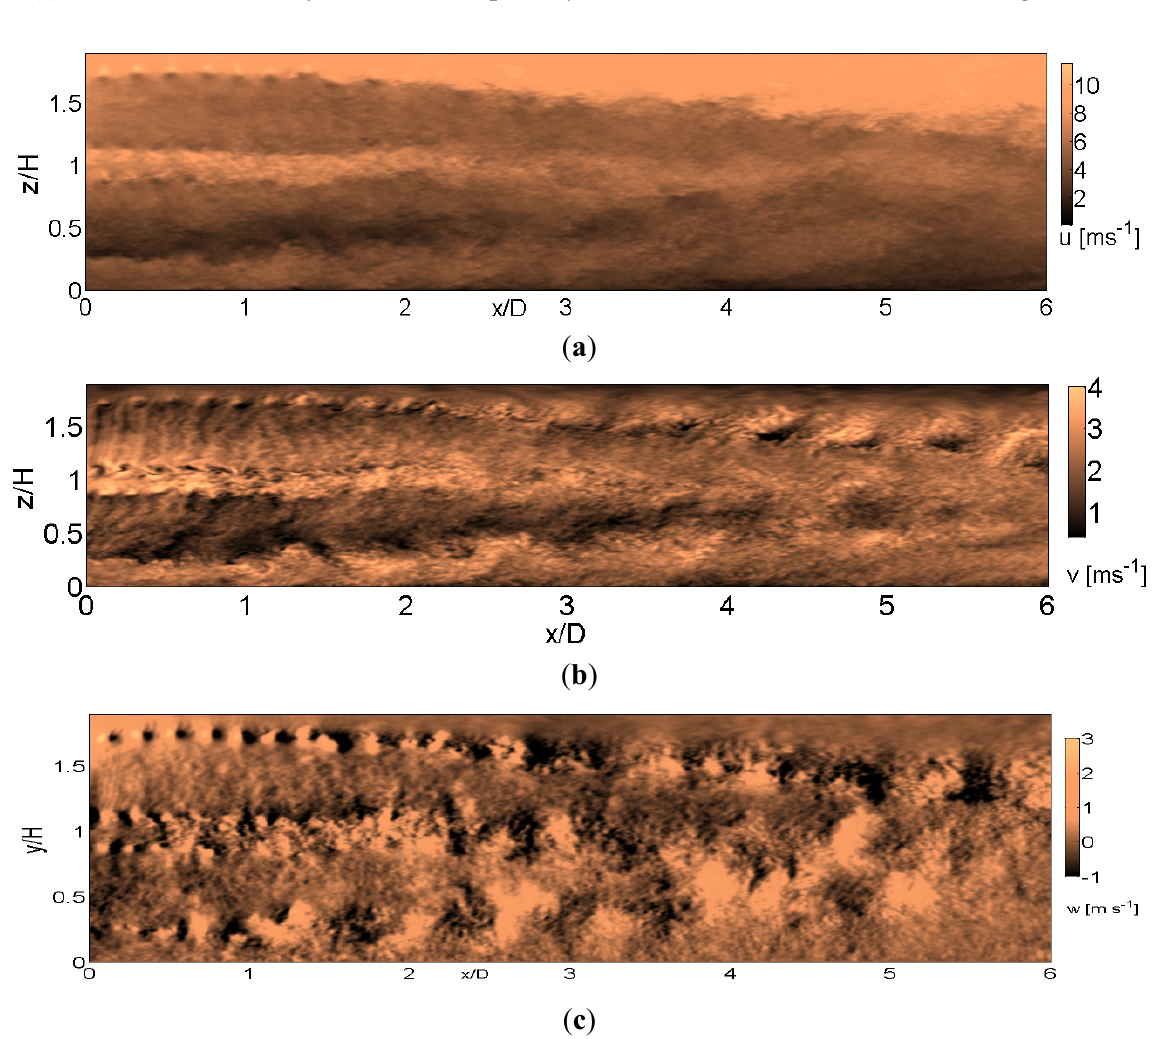
Figure 4. Velocity structure of the ( a ) streamwise velocity; ( b ) spanwise